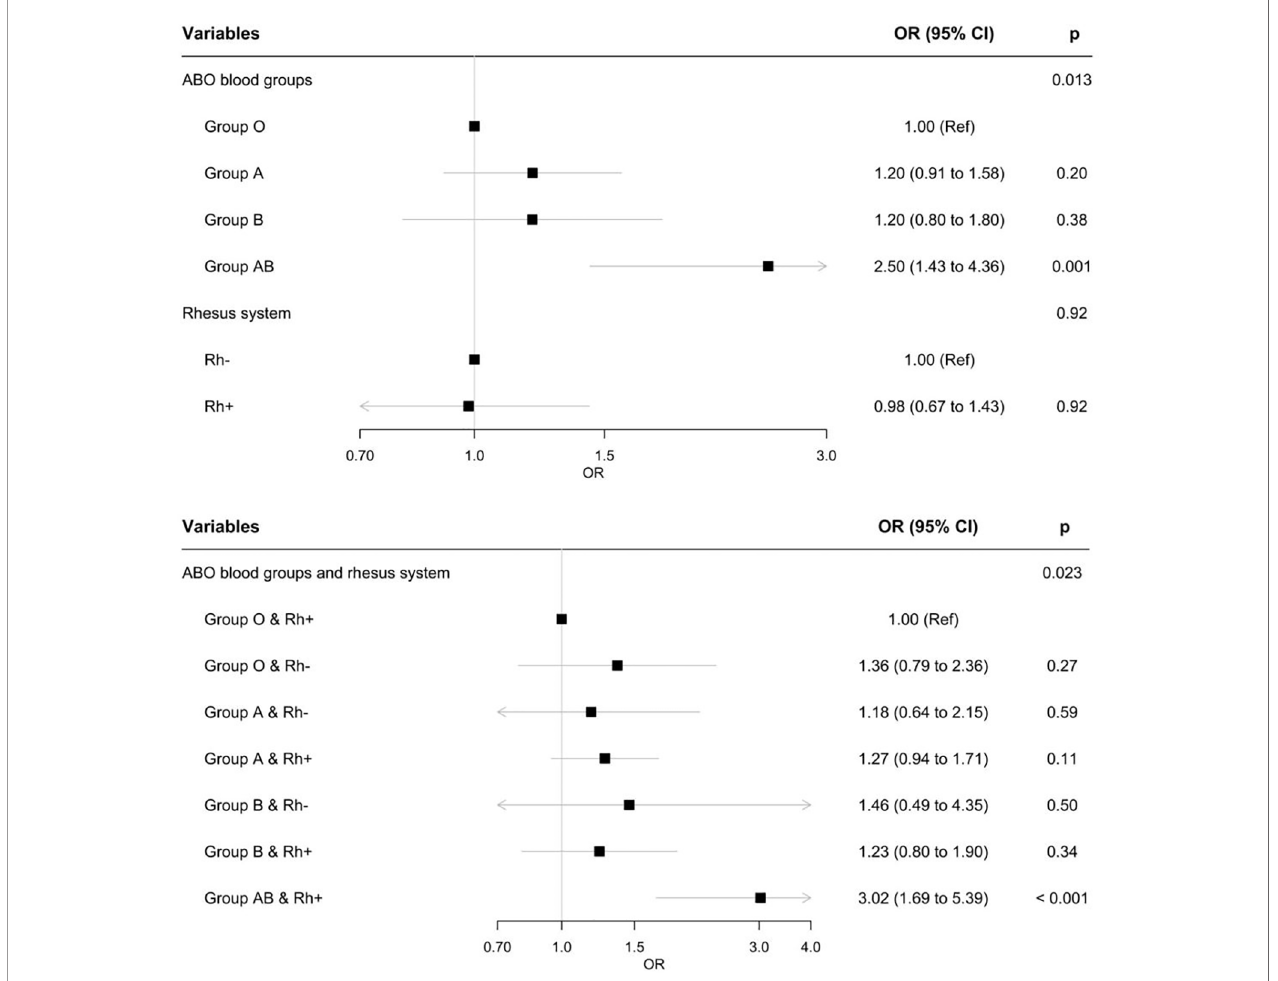
FIGURE 2 | Associations between ABO blood groups and GDM, between the Rh phenotype and GDM, and combinations of ABO and Rh phenotypes and